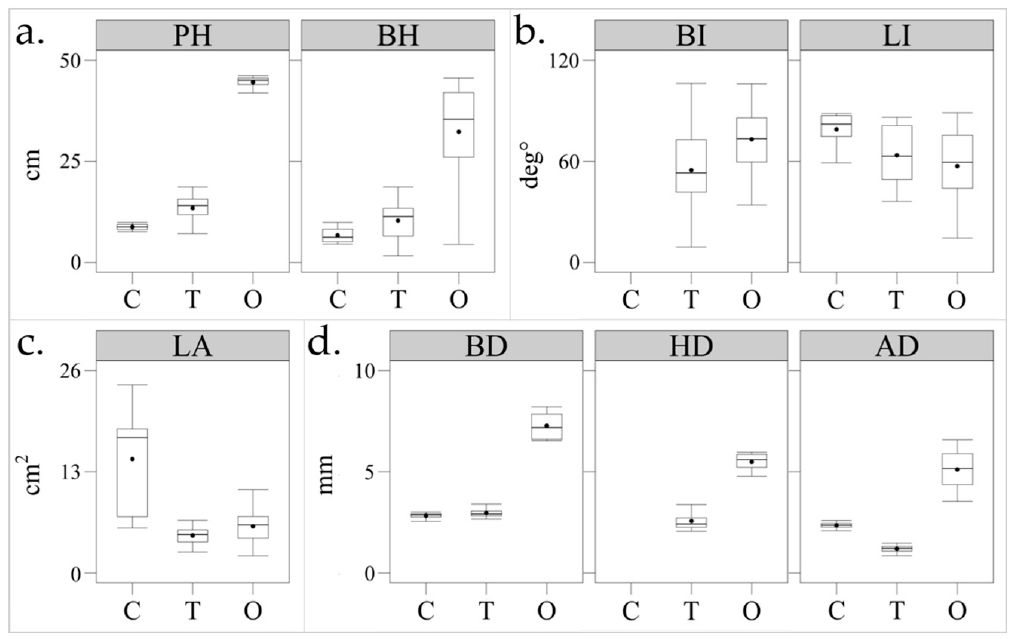
Figure 2. Observed morphological values of: ( a ) plant height ( PH ) and branches heights ( BH ), ( b ) leaves ( LI ) and branches inclination ( BI ), ( c ) single-leaf area ( LA ) and ( d ) basal ( BD ), half-plant ( HD ) and apical ( AD ) stem diameter for maize ( C ), tomato ( T ) plants and olive trees ( O ) considered in the study.